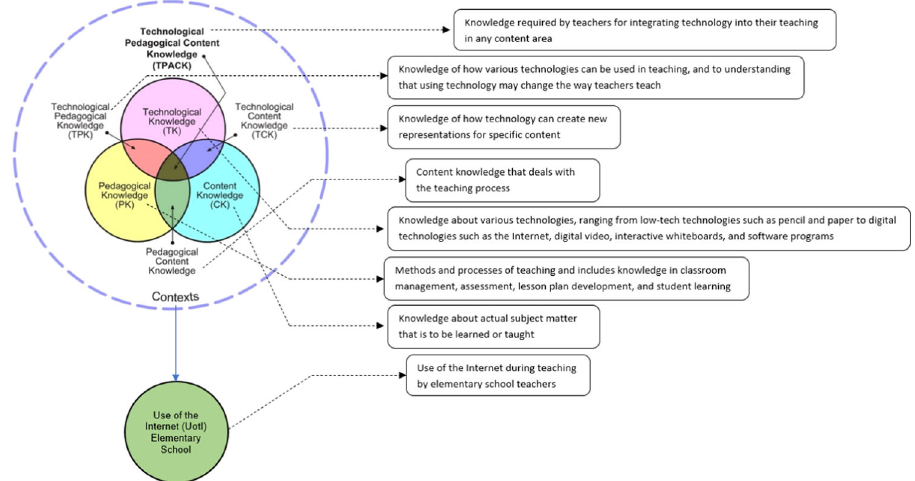
Fig. 1 TPACK-UotI and their de fi nitions. TPACK variables (TK, CK, PK, TPK, TCK, PCK, and TPACK) were combined with the Use of the Internet